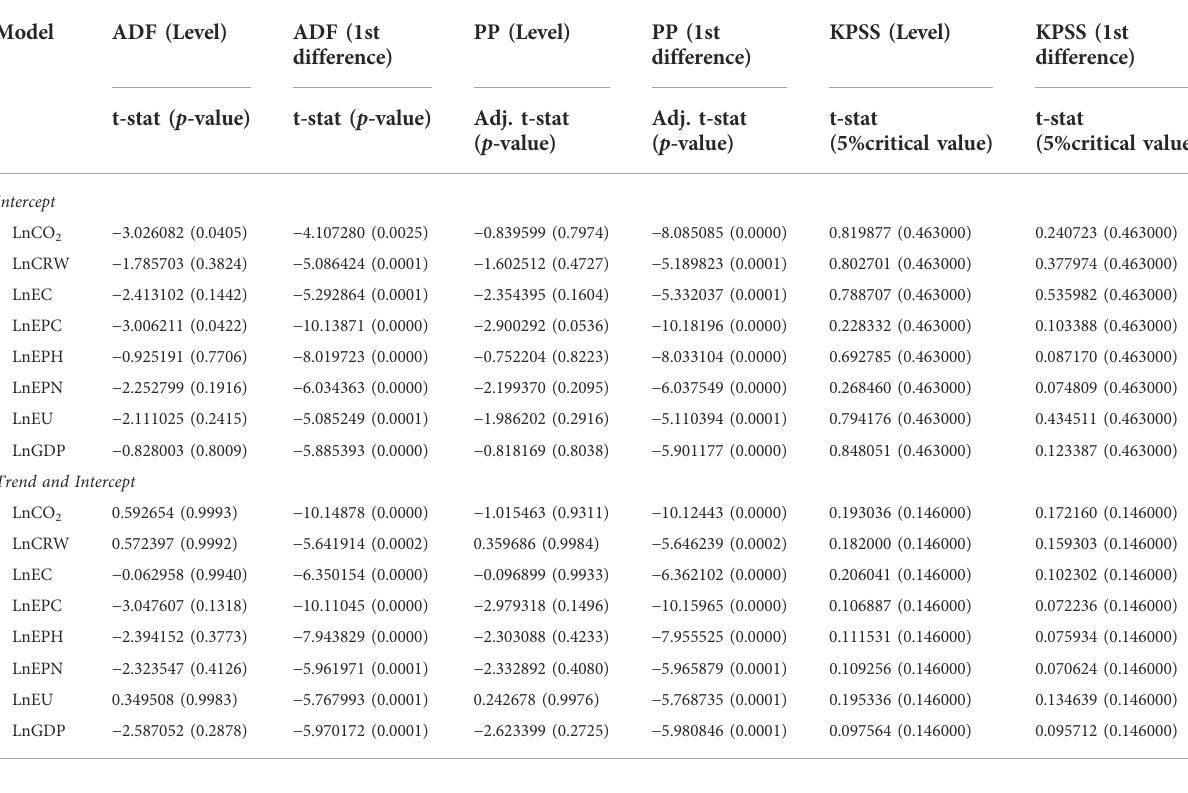
TABLE 4 Results of unit root analysis.